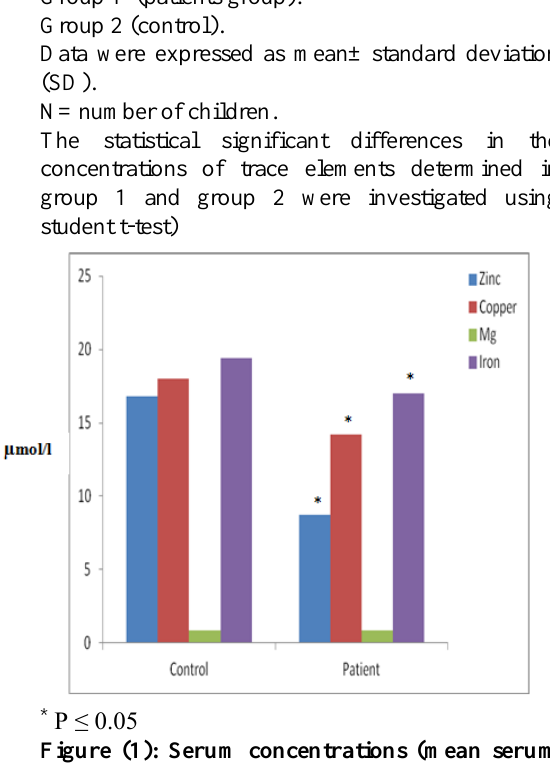
Figure (1): Serum concentrations (mean serum concentrations) of trace elements in control group and patients group of